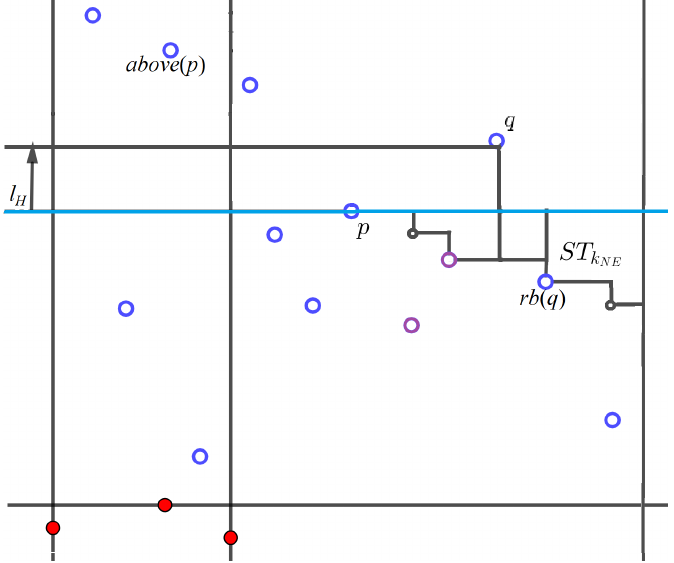
Figure 4. Case 1. p ∈ B NE , q to the right of p . The purple empty dots denote T ( p , q )